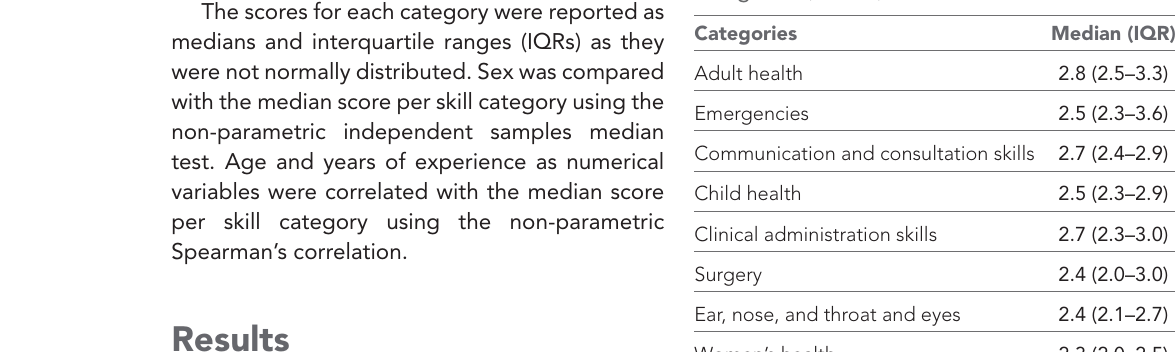
Table 2 Performance of key clinical skills